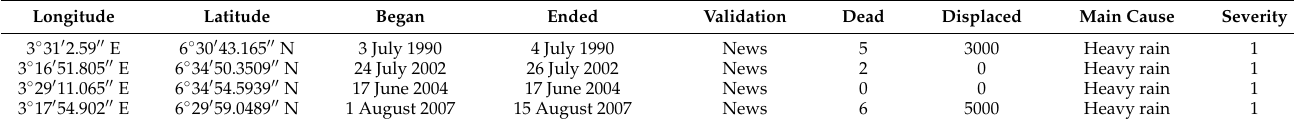
Table 7. Dartmouth Flood Observatory reported flood events in the study area.